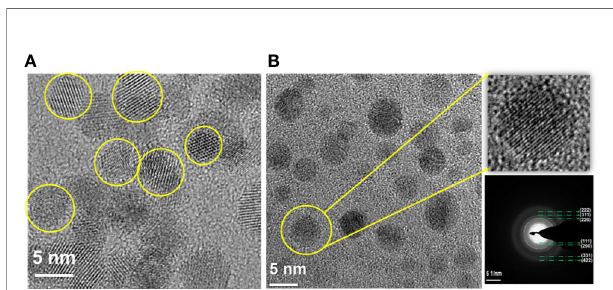
FIGURE 1 | Morphological characterization of nanostructures, (A) CNP and (B) CNP-miR146a. (A) Well crystalline spherical shape control CNP particles in the size of 3 – 5 nm. (B) CNP-miR146a conjugates with a stabilized and dispersed spherical particle of 3 – 7 nm size, with a very thin coating (dark shading) on the nanoparticles, showing the conjugated miR146a. The selected area electron diffraction (SAED) pattern [(111), (200), (220), (311), (222), (331), and (422)] con fi rms the diffraction rings match the cubic structure of